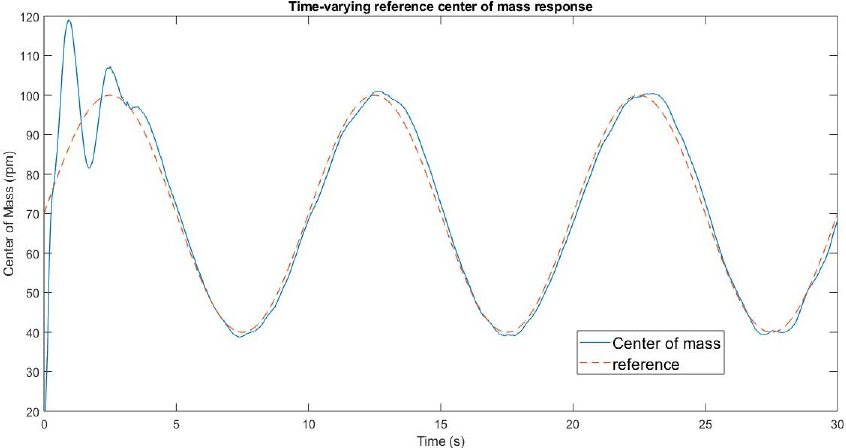
Figure 9. Experimental center of mass of agents following a sinusoidal